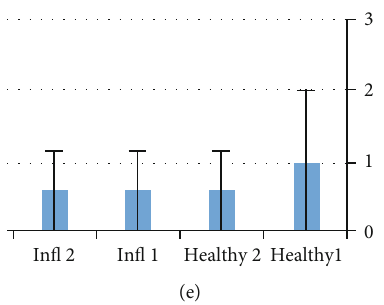
Figure 2: (a) Flow cytometric analysis of the surface marker expressions CD90, CD73, and CD105 in healthy gingival tissues. (b) Flow cytometric analysis of the surface marker expressions CD90, CD73, and CD105 in in fl amed gingival tissues. (c) Alizarin red staining of calcium deposits of GMSCs in osteogenic medium, Oil Red staining of oil droplets of GMSCs in adipogenic medium, and Alican blue staining of cartilage glycoprotein of GMSCs in chondrogenic medium and their respective controls. (d) Population doubling time assay with means and standard deviation of the of GMSCs from healthy and in fl amed gingival tissues, with signi fi cantly shorter population doubling time in the in fl amed group. (e) Graph showing colony-forming unit assay with means and standard deviation of the of GMSCs from healthy and in fl amed gingival tissues.